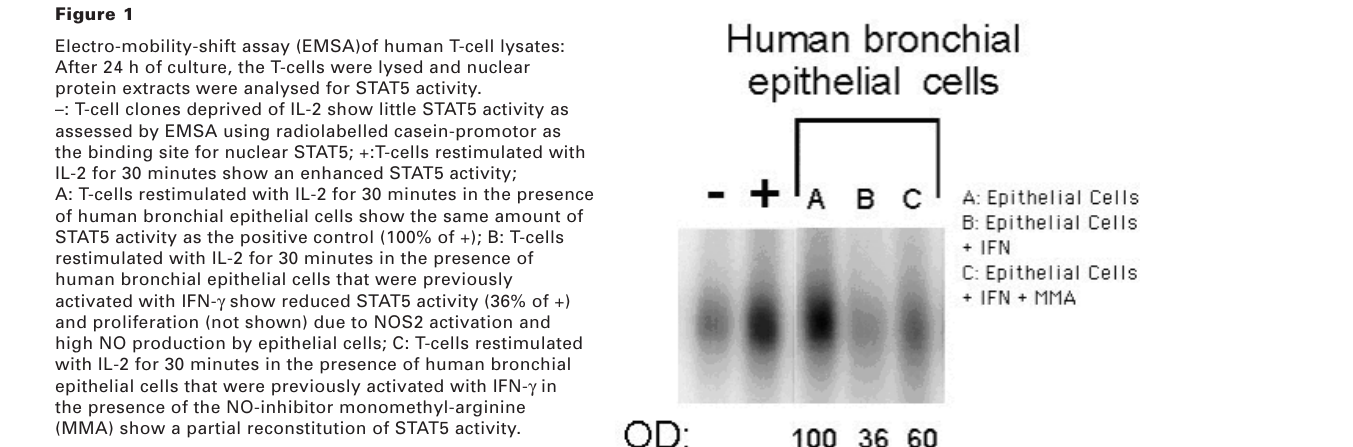
Electro-mobility-shift assay (EMSA)of human T-cell lysates: After 24 h of culture, the T-cells were lysed and nuclear protein extracts were analysed for STAT5 activity. –: T-cell clones deprived of IL-2 show little STAT5 activity as assessed by EMSA using radiolabelled casein-promotor as the binding site for nuclear STAT5; +:T-cells restimulated with IL-2 for 30 minutes show an enhanced STAT5 activity; A: T-cells restimulated with IL-2 for 30 minutes in the presence of human bronchial epithelial cells show the same amount of STAT5 activity as the positive control (100% of +); B: T-cells restimulated with IL-2 for 30 minutes in the presence of human bronchial epithelial cells that were previously activated with IFN- γ show reduced STAT5 activity (36% of +) and proliferation (not shown) due to NOS2 activation and high NO production by epithelial cells; C: T-cells restimulated with IL-2 for 30 minutes in the presence of human bronchial epithelial cells that were previously activated with IFN- γ in the presence of the NO-inhibitor monomethyl-arginine (MMA) show a partial reconstitution of STAT5